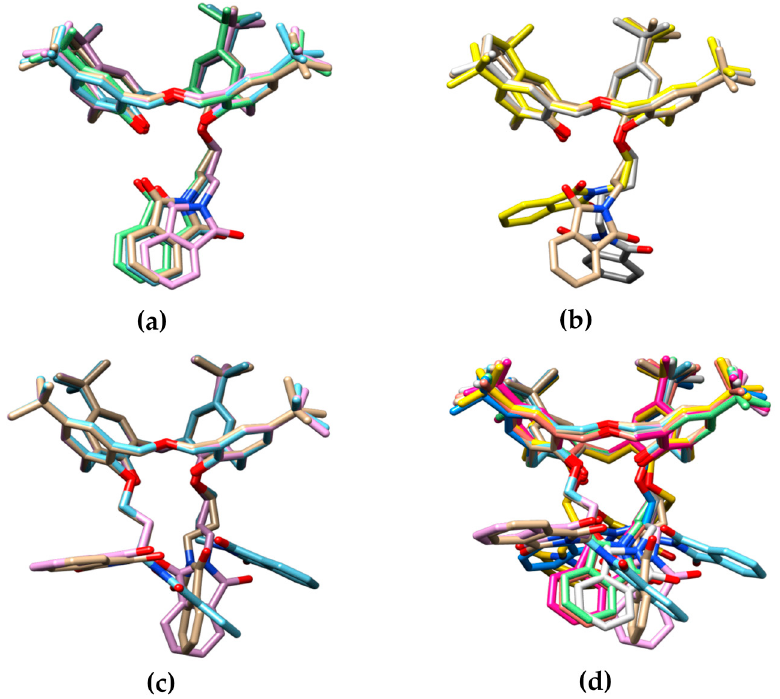
Figure 6. Comparison of the conformations of the phthalimide arms. All molecules exhibit very similar cone conformations: ( a ) Overlay of the 4 independent molecules of 2a ; ( b ) Overlay of 5a (ethyl linker) one of the 4 independent molecules of 2a (propyl linker) and the analogous derivative with butyl linker [35]; ( c ) Overlay of the 3 independent molecules of 3a ; ( d ) Overlay of the 9 independent molecules of 2a , 3a , 3b and 5a . The atomic species are represented in CPK colors. Hydrogen atoms, atom disorder and solvent molecules are omitted for clarity.